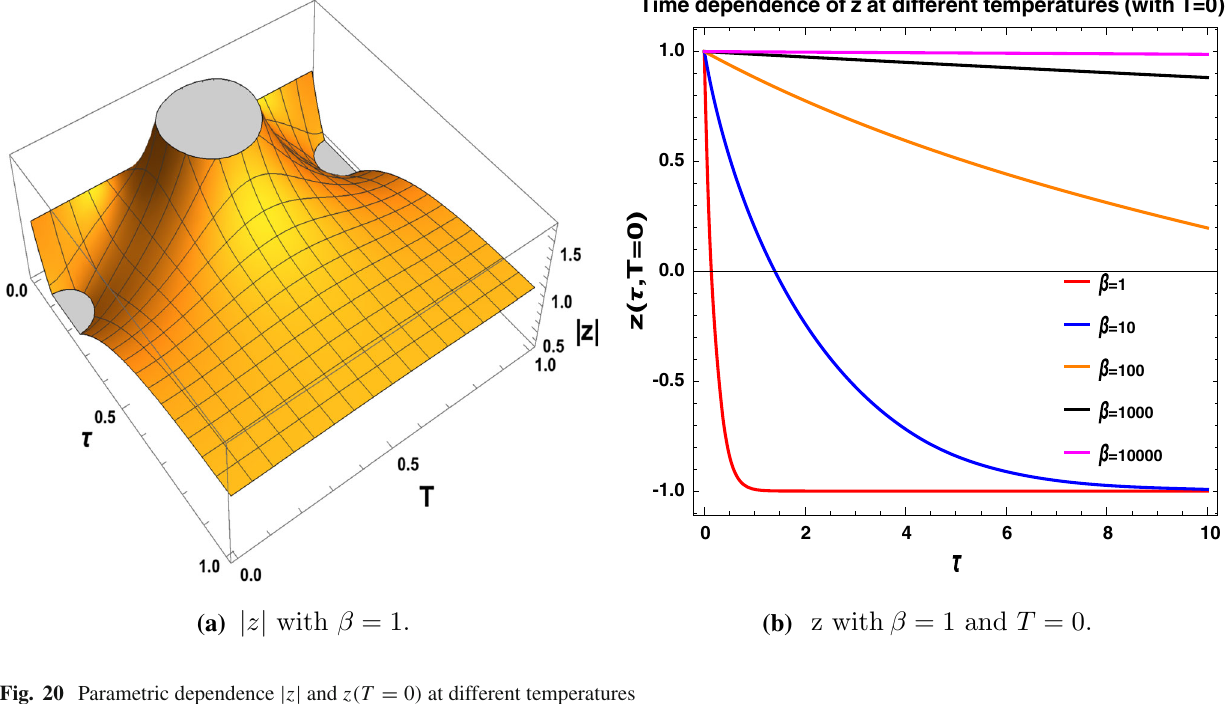
Fig. 20 Parametric dependence | z | and z ( T = 0 ) at different